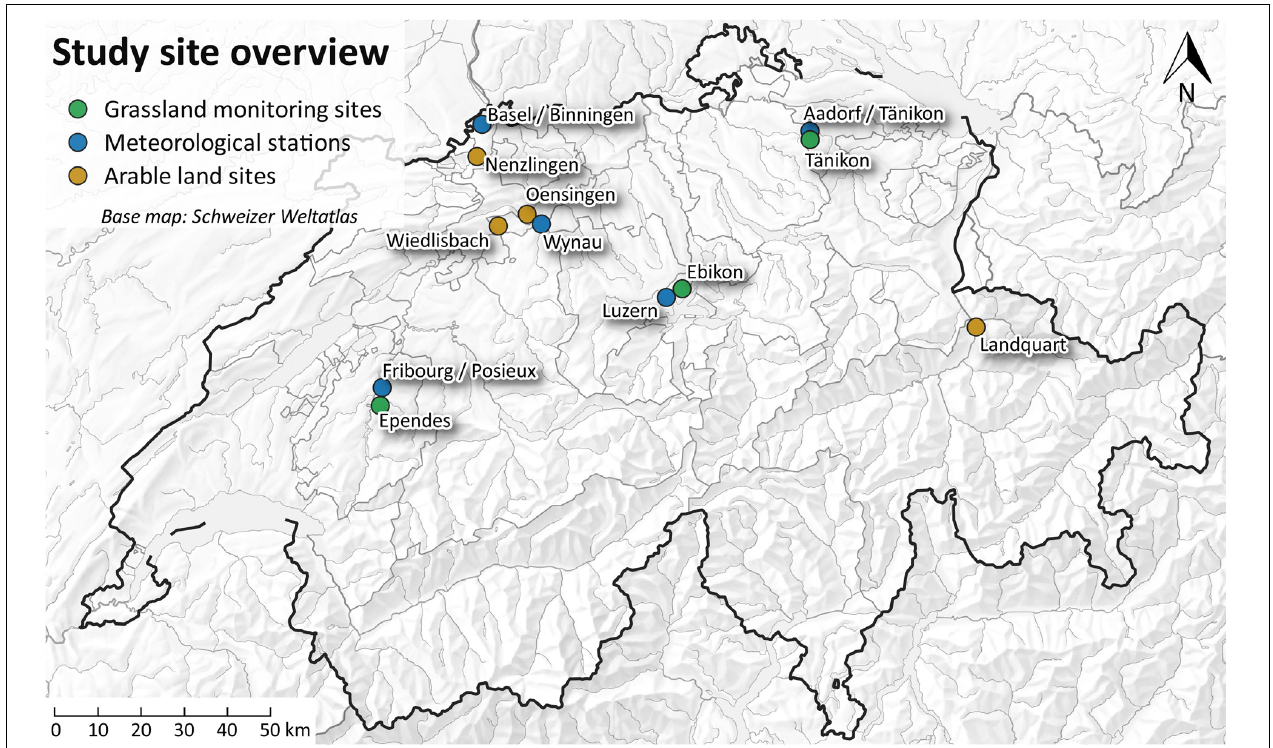
FIGURE 1 | Map of Switzerland with the locations of the study sites and the meteorological